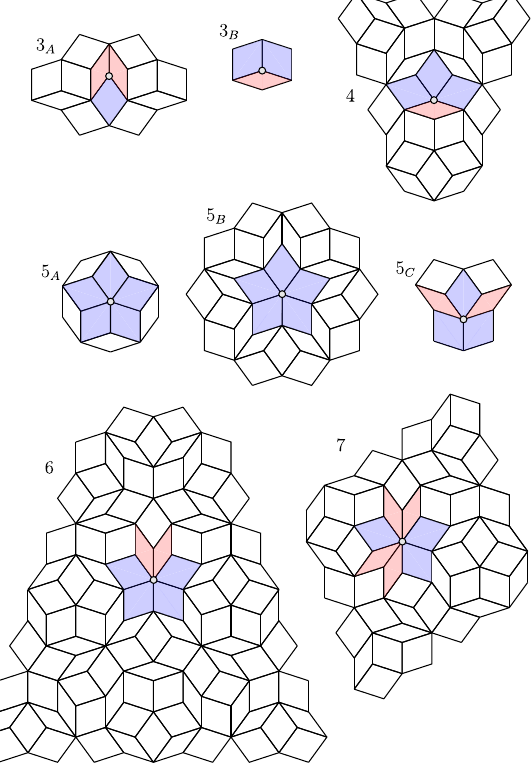
FIG. 4. Each vertex type in Fig. 3 is accompanied by a set of tiles which always appears around it, termed a local empire